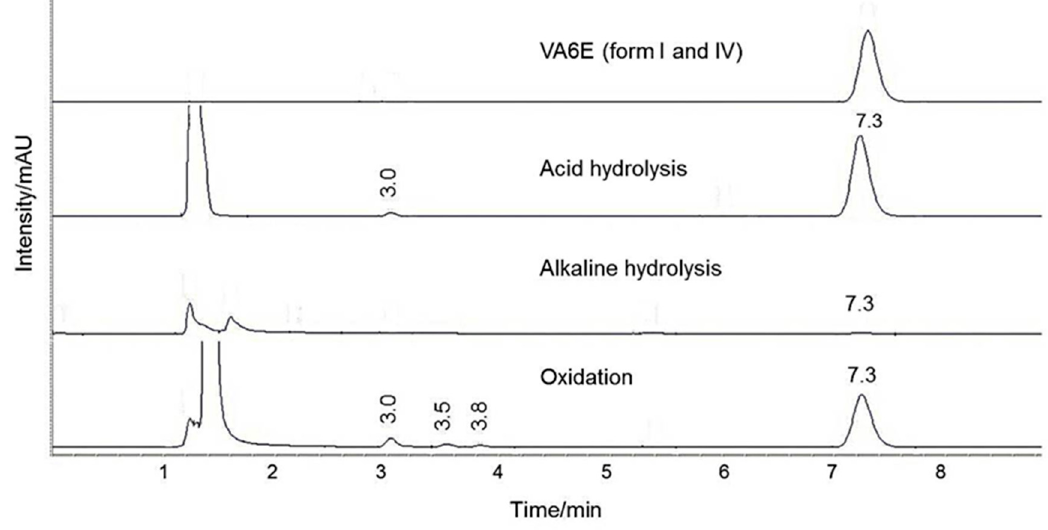
Figure 9. VA6E (form I and IV) chromatogram before and after 24 h application of diverse stress conditions: acid and alkaline hydrolysis and oxidation.